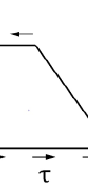
Fig. 5 Technical shear strain of the interlayer and its calculation